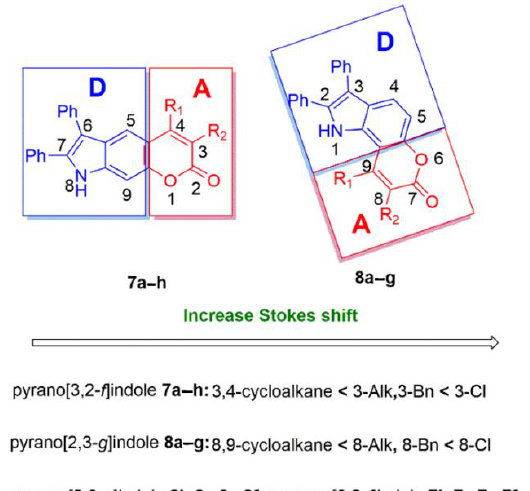
Figure 9. Charge separated structures of two isomeric pyranoindoles with linear [3,2- f ] ( 7e ) and angular [2,3- g ] ( 8e ) type of ring fusion.